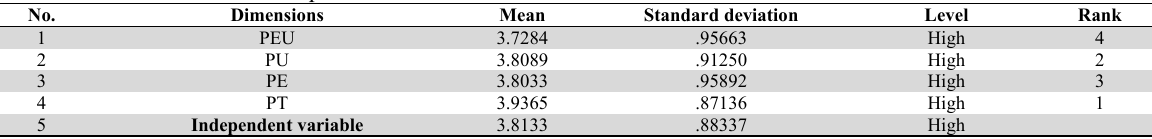
Means for the dimensions of independent variables No.